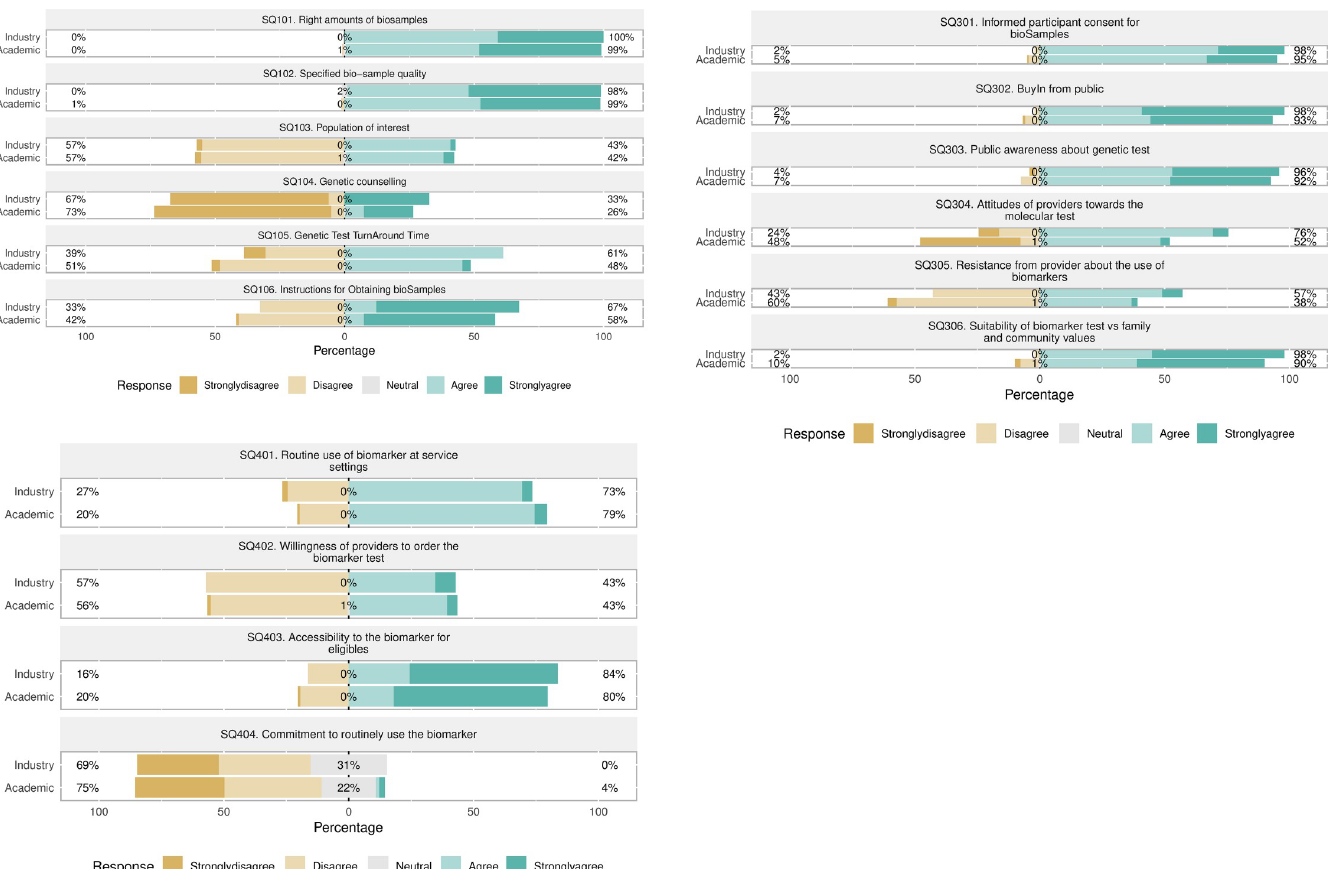
Fig 5. A. Survey responses to questionnaire section on characteristics of omics biomarkers. B. Survey responses on public genomic awareness presented as “user response”(UsR). C. Diverging stacked bar-charts for survey responses on implementation outcomes (ImO) construct.